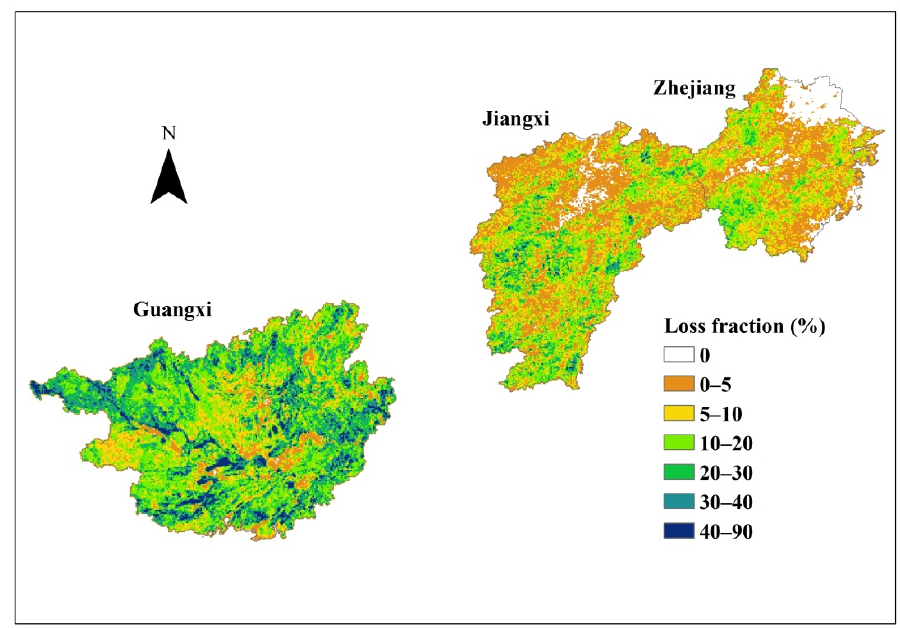
Figure 8. The aggregated (3 km × 3 km) total forest loss fractions in Guangxi, Jiangxi, and Zhejiang Provinces during 1986–2019.